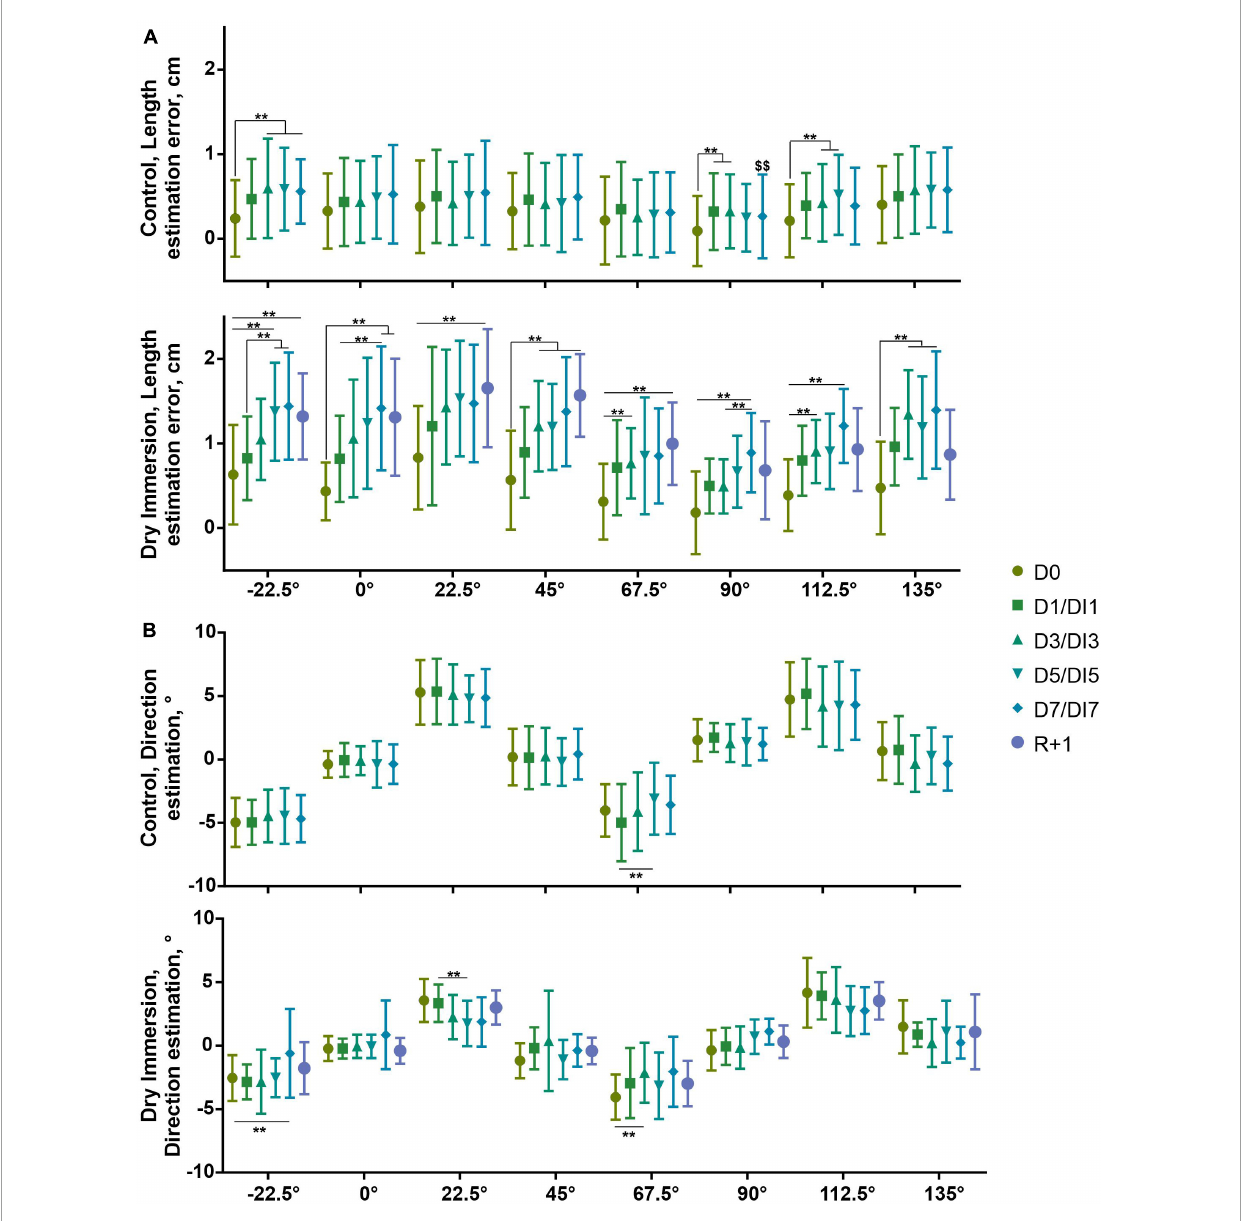
FIGURE3 Estimation of length (A) and direction (B) of segments of different orientation at reproduction stage in control ( n = 22) and DI ( n = 10) groups. Abscissa–orientation of given segment. D0–1st day of measurements in control and DI groups. D1, D3, D5, and D7–2nd, 4th, 6th, and 7th day of measurements in the control group, respectively. These days correspond to DI1, DI3, DI5, and DI7–1st, 3rd, 5th, and 7th day of DI. R + 1–the measurement performed 1 day after the end of the DI procedure. Mean ± SD. $$ p < 0.01 in relation to horizontal segment, ** p < 0.01 in relation to the estimation of the segment of the same orientation on other